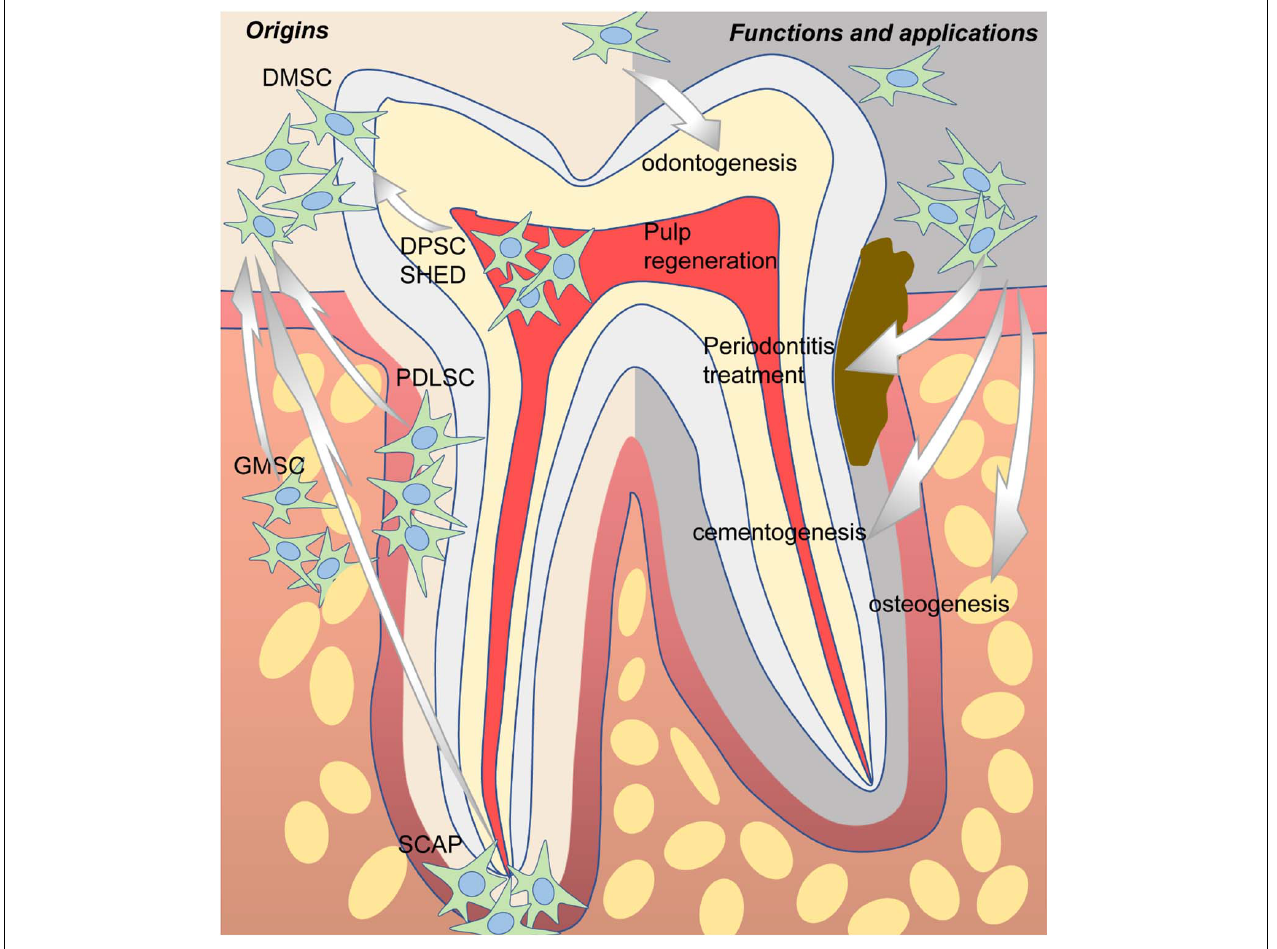
FIGURE 1 | The origins, potential functions, and applications of dental-derived mesenchymal stem cells